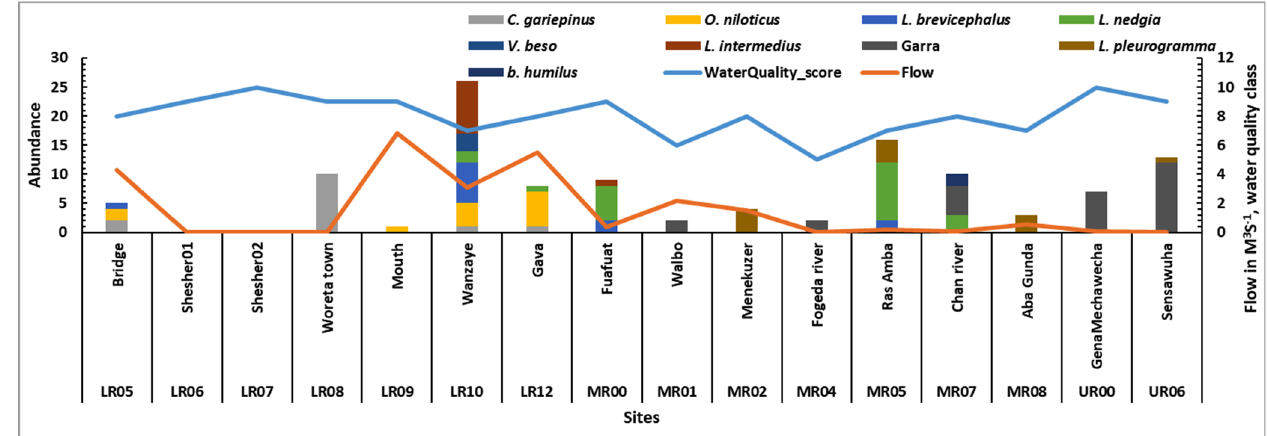
Figure 7. Relationship of fish abundance with water quality class and flow in the Gumara River. LR—lower reach, MR—middle reach and UR—upper reach.